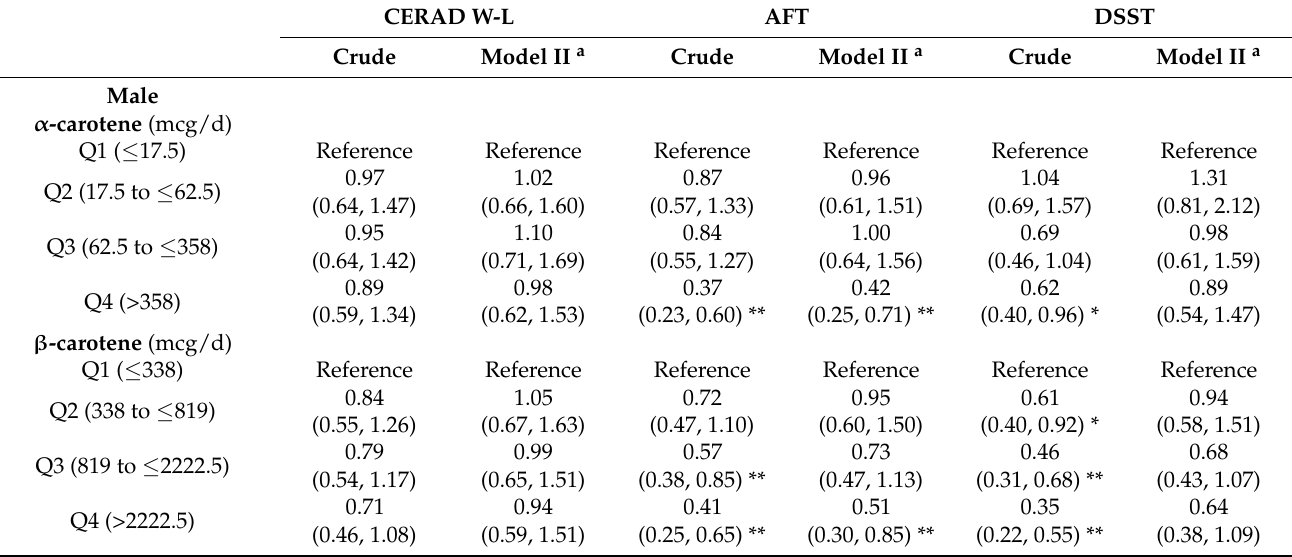
Figure 2. Dose–response relationships between dietary α -carotene and β -carotene intake and cognitive performance. ( a ) Restricted cubic spline model of the ORs of the AFT decline with Ln-transformed dietary α -carotene intake; ( b ) Restricted cubic spline model of the ORs of the CERAD W-L decline with Ln-transformed dietary β -carotene intake; ( c ) Restricted cubic spline model of the ORs of the DSST decline with Ln-transformed dietary β -carotene intake; ( d ) Restricted cubic spline model of the ORs of the AFT decline with Ln-transformed dietary β -carotene intake. All models were adjusted for age, gender, race/ethnicity, BMI, education, marital status, poverty-income ratio, smoking status, alcohol intake, and diabetes. Table 3. Weighted odds ratio (95% confidence intervals) of low cognitive performance by quartiles of dietary α -carotene and β -carotene intake, stratified by